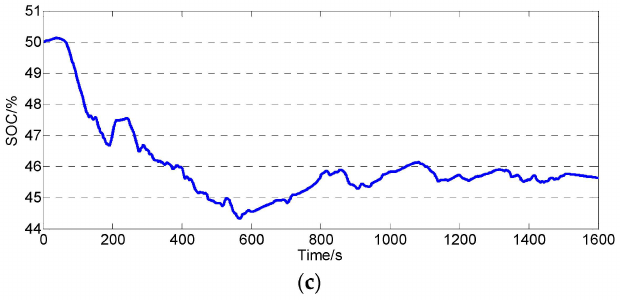
Figure 12. Simulation results for battery-only ESS: ( a ) Battery bank current; ( b ) Battery bank voltage; ( c ) SOC of the battery